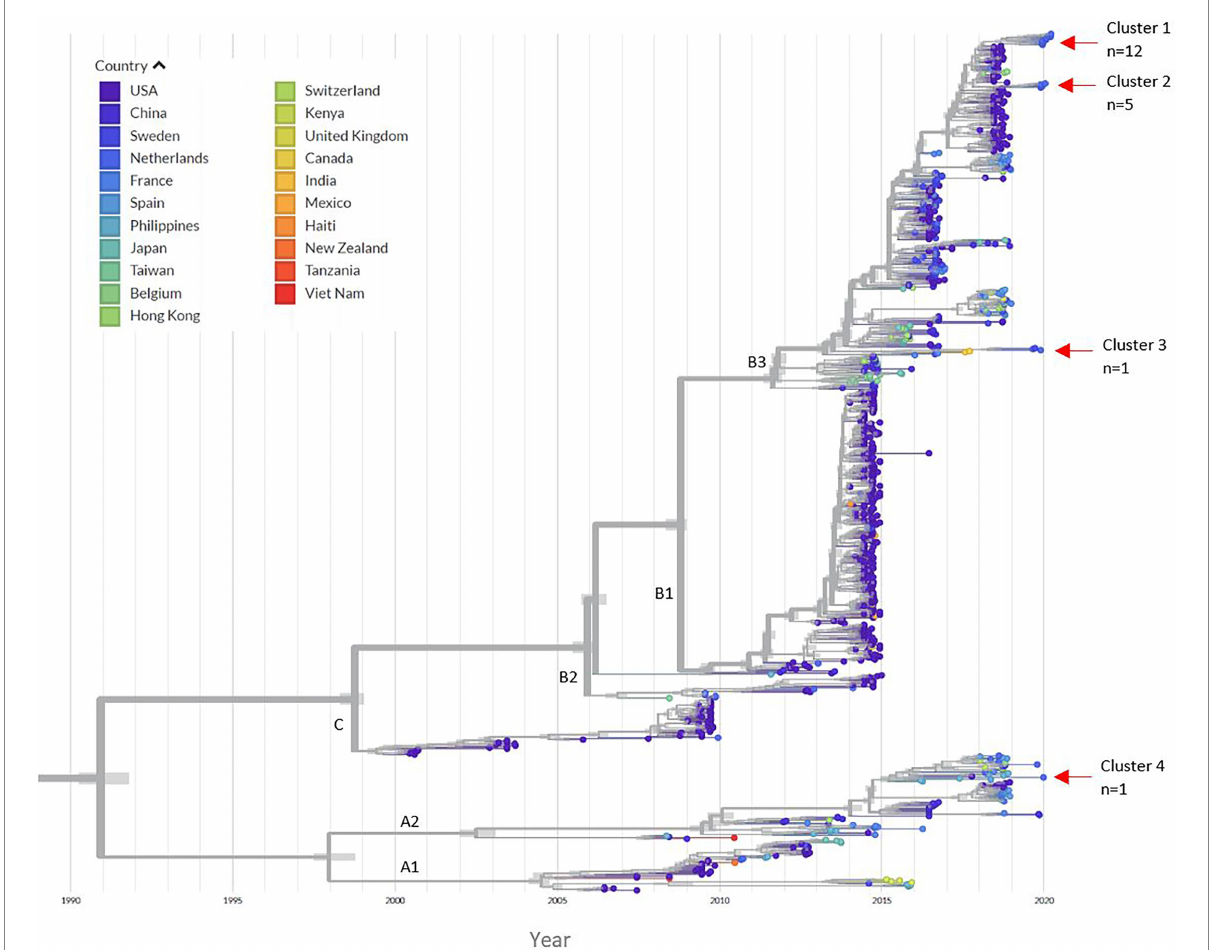
FIGURE 2 Time-scaled phylogenetic tree. The left panel indicates the corresponding countries to each EV-D68 sequence in the tree. The red arrows indicate the location of the four different clusters of our 2019/2020 patient samples. From the 892 references downloaded; 21 sequences were manually removed due to poor quality after the initial alignment (Supplementary Table S8). A total of 872 sequences were run through the Nextstrain pipeline. An additional 29 references were removed after a second alignment. The Nextstrain pipeline automatically removed problematic sequences during tree refinement ( n = 12 references) and uploading to auspice ( n = 7 references), this included EVD68_GR_05_02.12.19 (Supplementary Table S8). A total of 824 EV-D68 references were included in the phylogenetic analysis. Supplementary Figures S4, S5 illustrate zoomed in images of the clusters. The time-scaled tree had an estimated evolution rate of 3.05 × 10 − 3